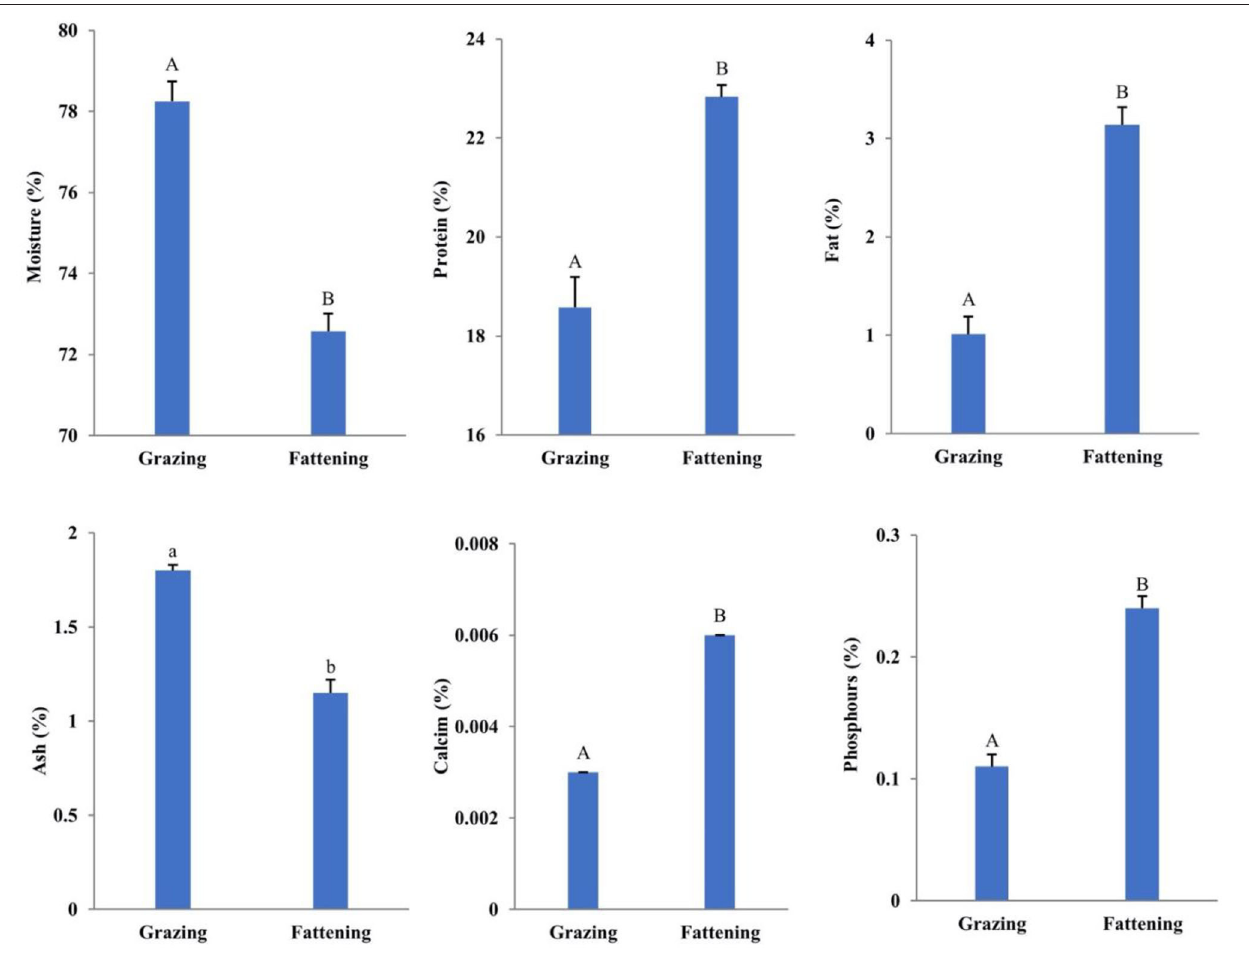
FIGURE 1 | Effects of intensive fattening with TMR on the content of moisture, protein, fat, ash, calcium, and phosphorus in LD of yaks. The six figures in Figure 1, respectively, show the contents of moisture, protein, fat, ash, calcium, and phosphorus in the LD nutrients of grazing and fattening yaks (%). In the same group, a and b represent significant differences ( P < 0.05), while A and B represent extremely significant differences ( P < 0.01). The data are all the actual test